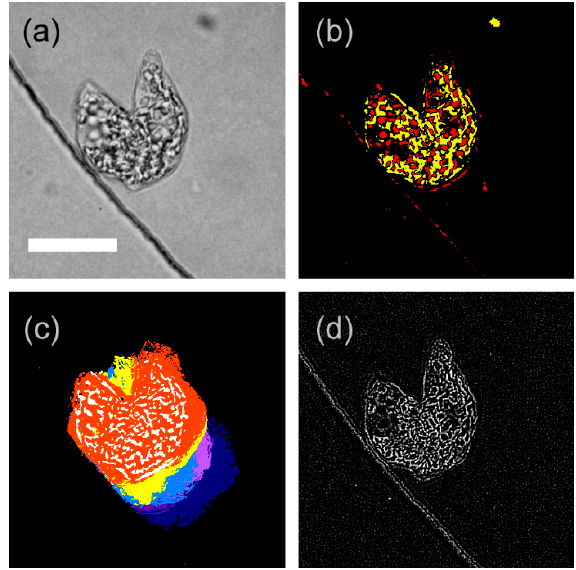
Figure 2. Examples of image processing for cell tracking, wherein a cell in the later stage of cell division at the edge line of circular microchamber was processed. ( a ) Captured image; obtained by 3 × 3 mean filtering with gray scaling. ( b ) Contrast image; obtained by thresholding brightness deviated from whole area average, i.e., the brighter part is colored in red, whereas the darker part is colored in yellow. ( c ) Trace image; obtained by time differential (frame-by-frame differential for each pixel) of the captured image, with further processing of binarization and integration for 20 frames (5.3 s). Five trace images were superimposed with different colors for effective visualization. ( d ) Focusing image; obtained by the spatial derivative for 3 × 3 pixels on the captured image. Scale bar, 20 μ m.